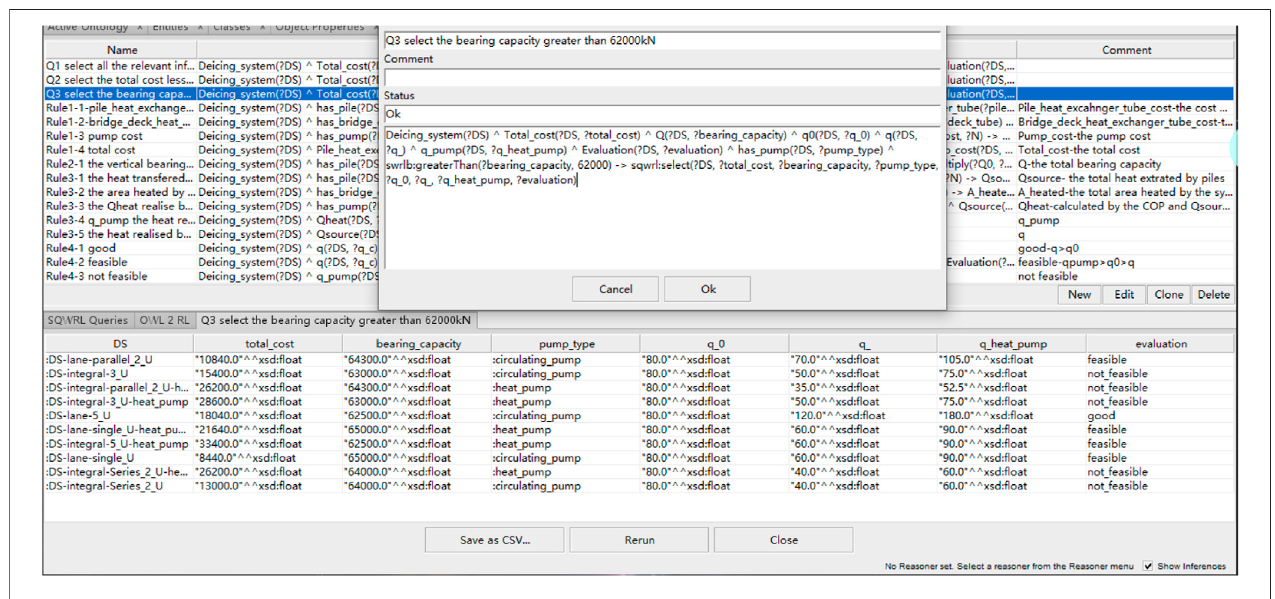
FIGURE 13 | Execution and results of querying Table 9 .